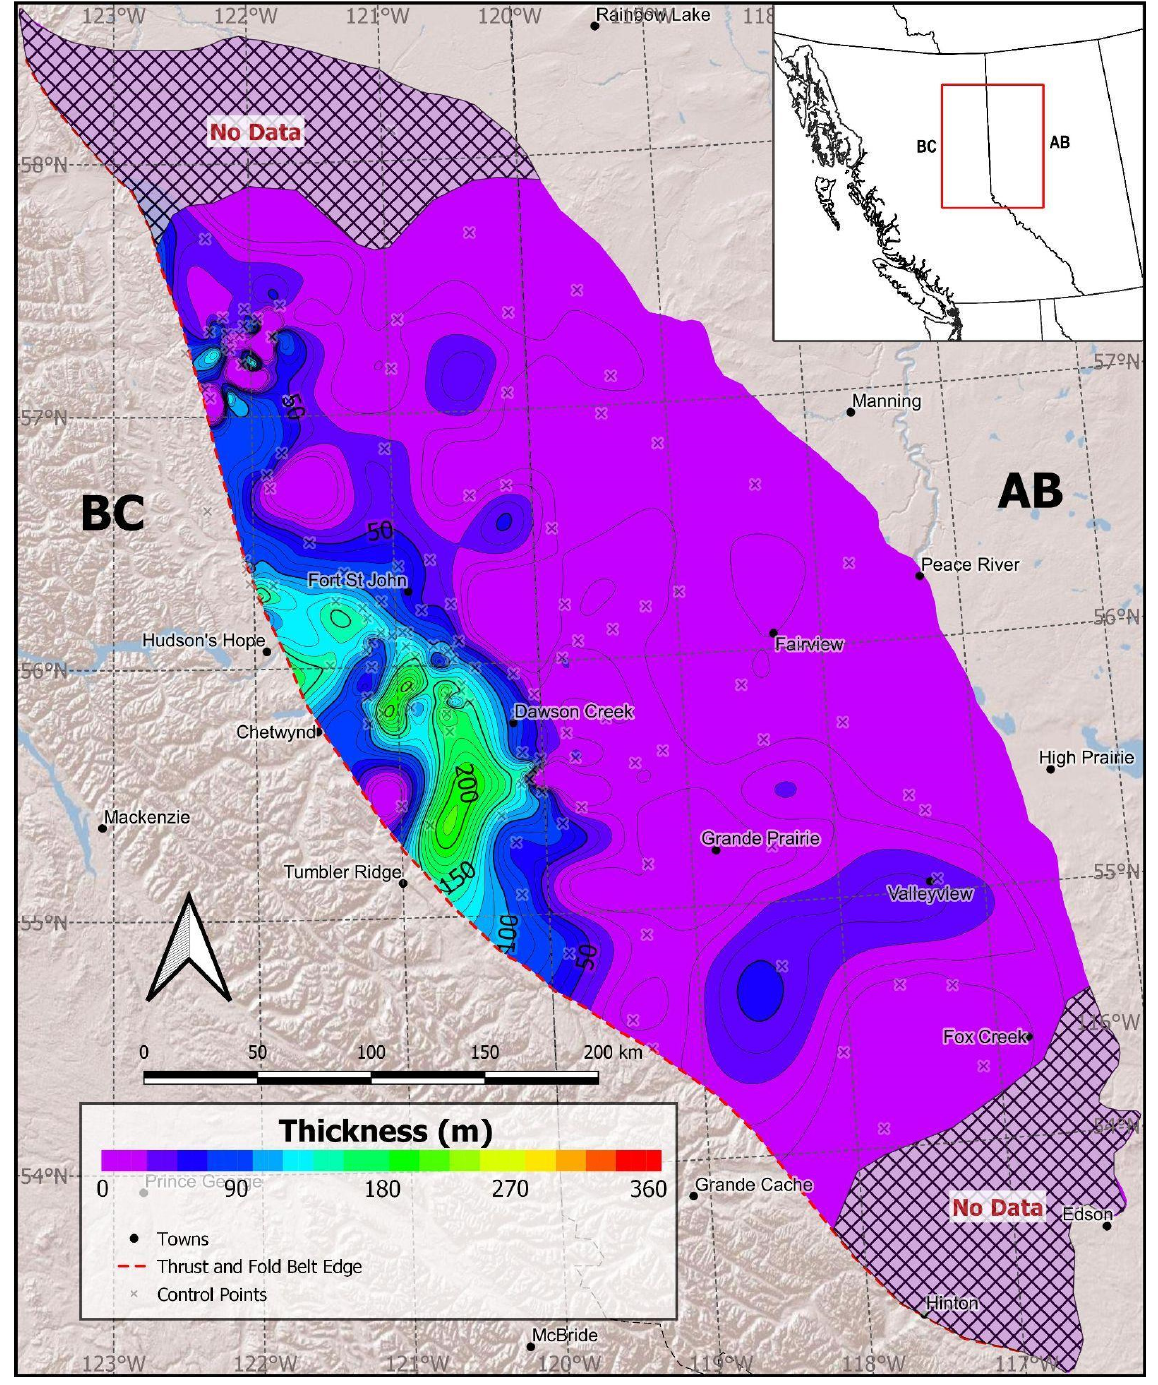
Figure 4. Thickness distribution of the Upper Montney Formation in British Columbia and Alberta. The distribution shows an increase in thickness towards the deformation front and within the structures of the Fort St. John Graben complex (see Figure 1). The Upper Montney Formation is thin to absent in Alberta.